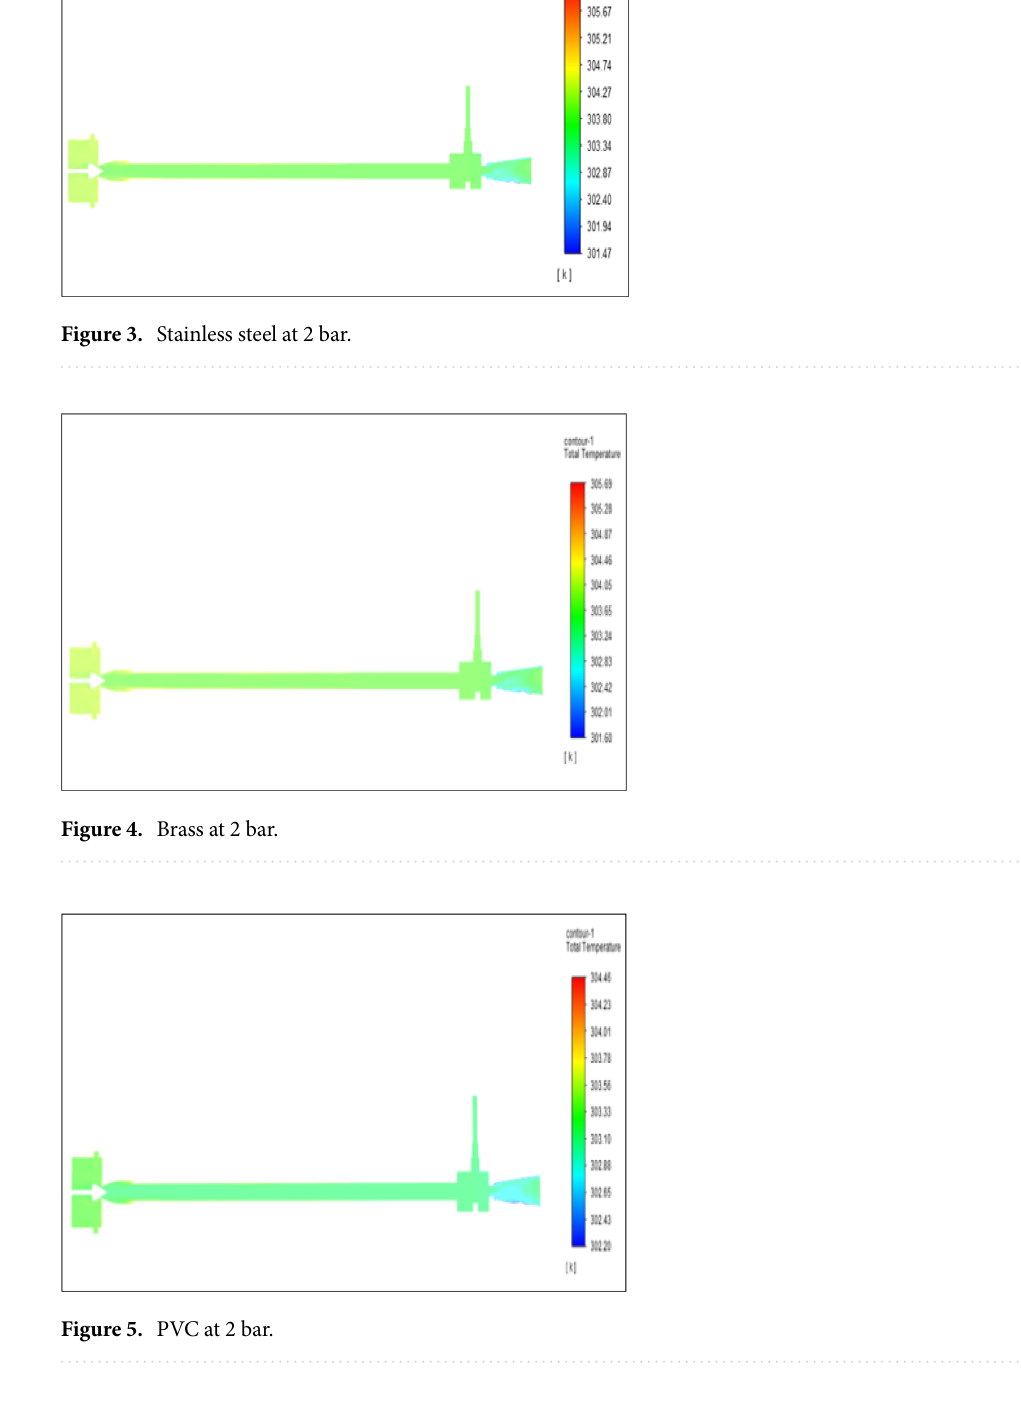
Figure 10 represents to copper vortex tube with an inlet pressure of 2 bars. The inlet temperature of the VT is 303 K. The hot air temperature was obtained at the hot end as 305.75 K and at the cold end side obtained a value of 301.96 K. The maximum temperature difference was found to be 3.78 K. Pressure at 4 bar. Figure 11 related to stainless steel vortex tube with an inlet pressure of 4 bars. The inlet temperature of the VT is 303 K. The hot air temperature was obtained at hot the end as 307.03 K. Similarly at cold end side obtained a value of 300.77 K. The Maximum temperature difference was found to be 6.25 K.